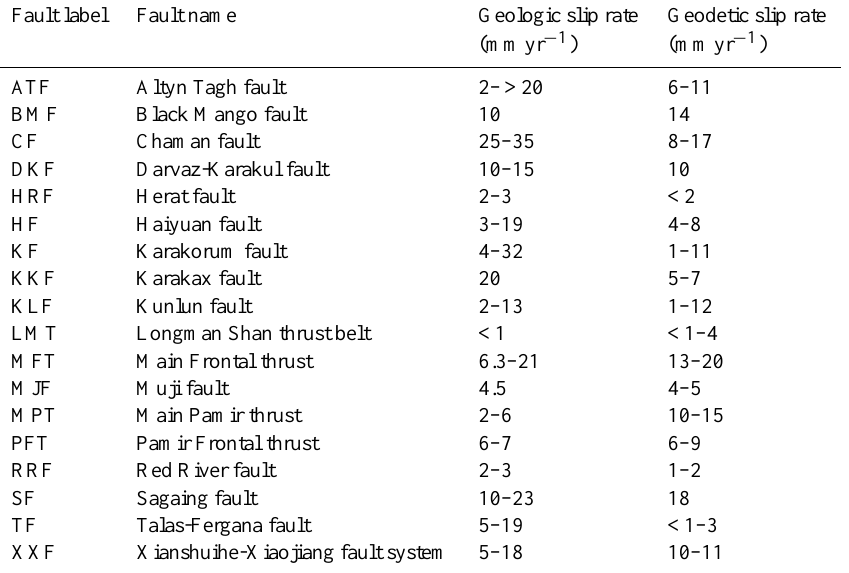
Table 4. Summary of Quaternary and geodetic fault slip rates. All rates are estimates and demonstrate the ranges of reported slip rate values for each fault. Fault labels are as in Fig.